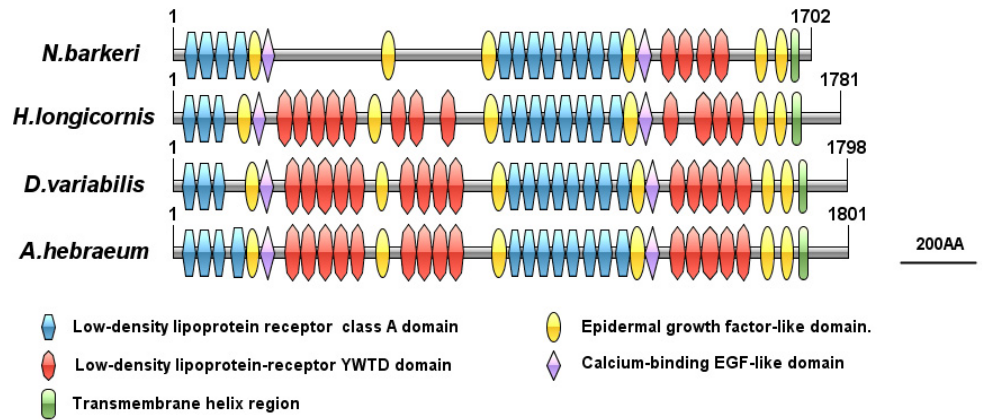
Figure 7. Schematic comparison of primary protein structures for the N.barkeri VgR with those of other mite species.